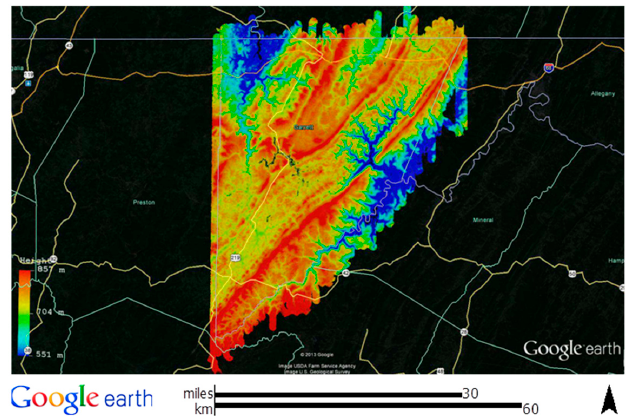
Figure 8. This color-coded elevation map of Garrett County, occupying approximately 1700 km 2 in the state of Maryland, was generated by HRQLS-1 from an AGL of 2.3 km. Total flight duration was approximately 12 h at an air speed of 278 km/h which included a 50% overlap between flight line, ferries, and turn maneuvers. The scanner was operating with a cone half angle of 17° resulting in a swath of 1.36 km and a mapping rate of 378 km 2 /h. Highest and lowest elevations are: red = 857 m, blue = 551 m.